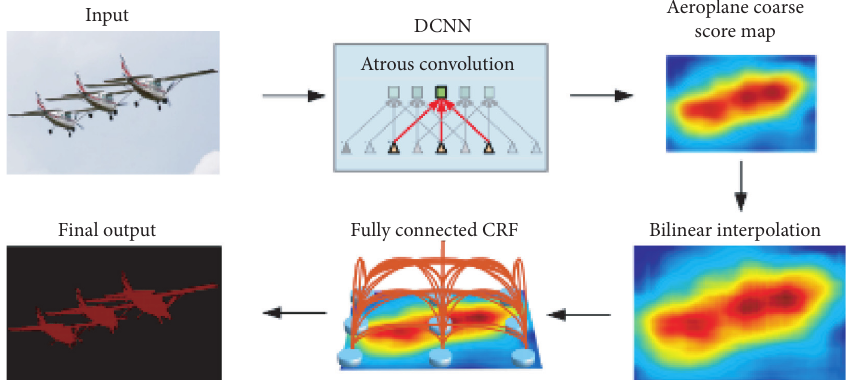
Figure 3: DeepLab framework with fully connected CRFs